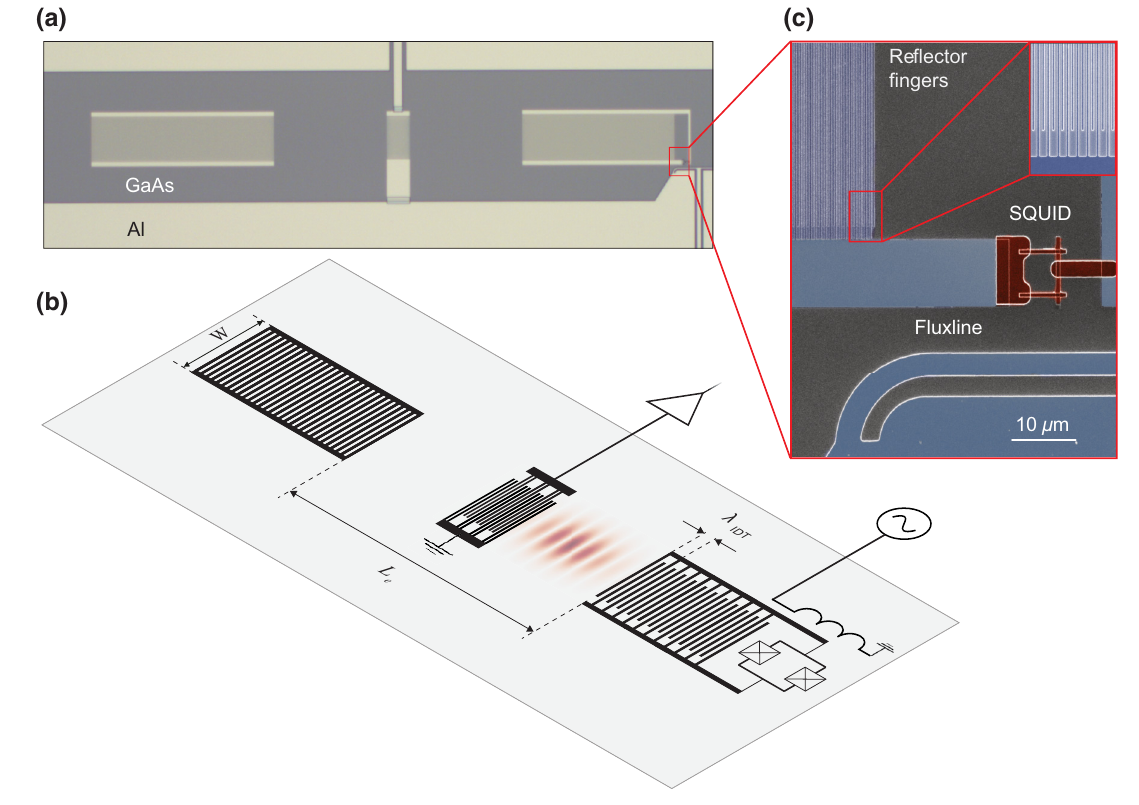
FIG. 1. Device layout. (a) Optical microscope image of the hybrid SAW resonator. The left Bragg reflector has 1200 fingers all shorted together. The reflector on the right-hand side has 500 unit cells of fingers alternatingly connected to either the top or bottom electrode, similarly to an IDT. As shown schematically in (b), the electrodes are shunted by a SQUID, which is modulated by a fluxline. The IDT at the center provides a single input and output port to the resonator. The unit cell of the IDT has a period of λ IDT = 736 nm and a double-finger structure to suppress mechanical reflections. (c) False-color scanning electron micrograph of the right-hand-side reflector with the SQUID and on-chip